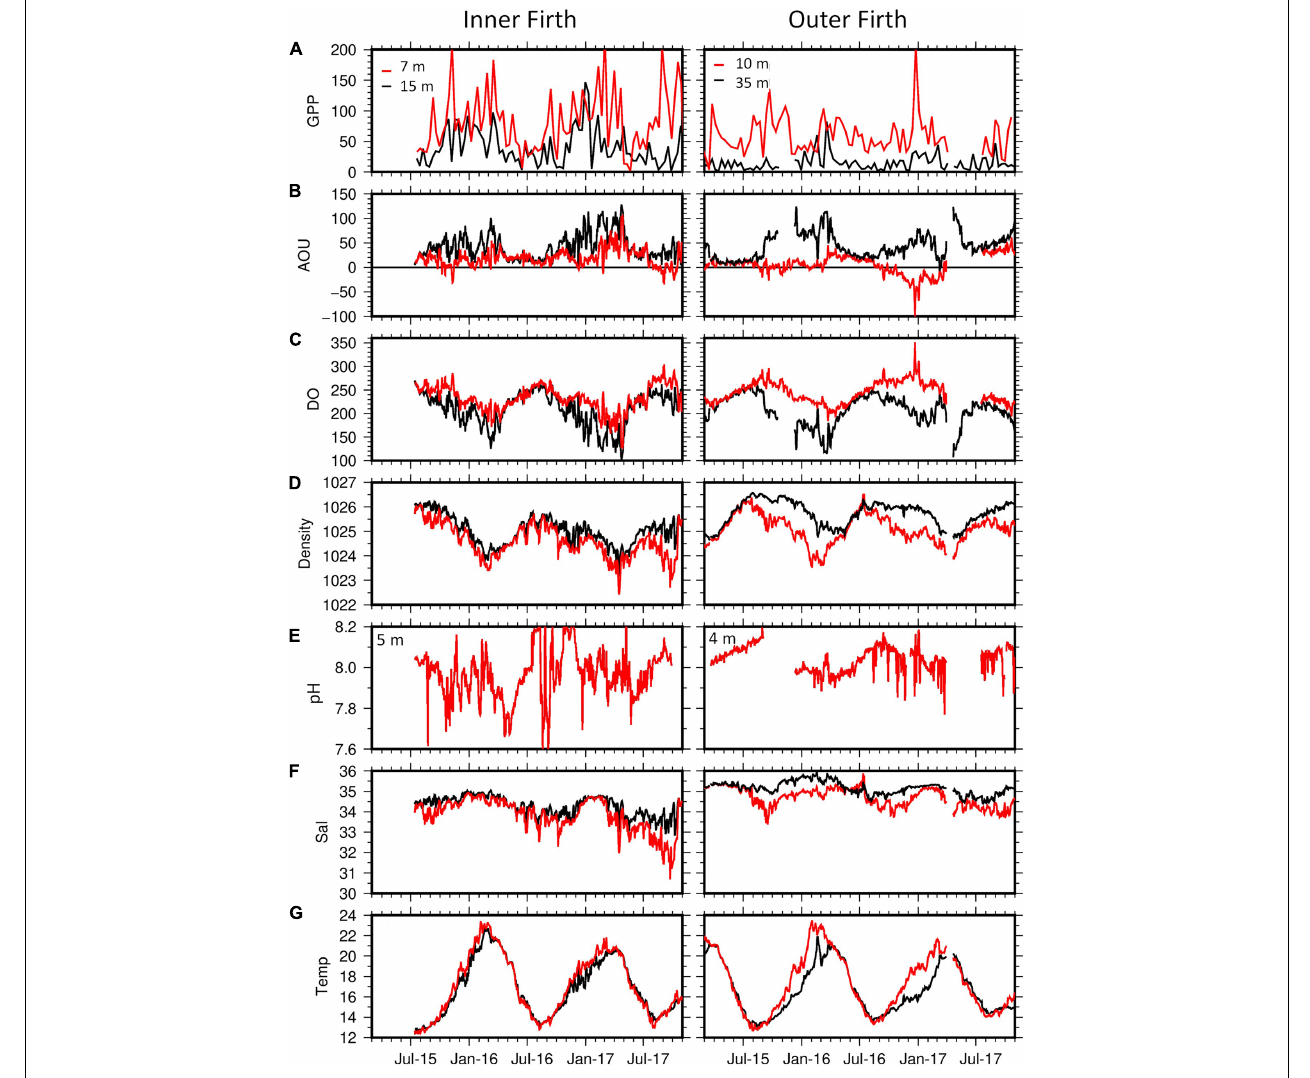
FIGURE 9 | Results from inner and outer Firth biophysical moorings ( Figure 1B ), from March 2015 to October 2017. The moorings carried temperature/salinity/O 2 sensors at upper and lower water column depths and pH sensors at upper column depths. (A) Gross Primary Production (mg C m − 3 d − 1 ) from diel O 2 variation, (B) Apparent Oxygen Utilization (AOU: µ mol kg − 1 ), (C) dissolved O 2 ( µ mol kg − 1 ), (D) seawater density (kg m − 3 ), (E) pH [ − log(H + )], (F) Salinity (practical salinity), (G) Temperature ( ◦ C). All instrument depths were as shown in (A) except pH, which were as shown in (E) . Gaps in the records were due to instrument